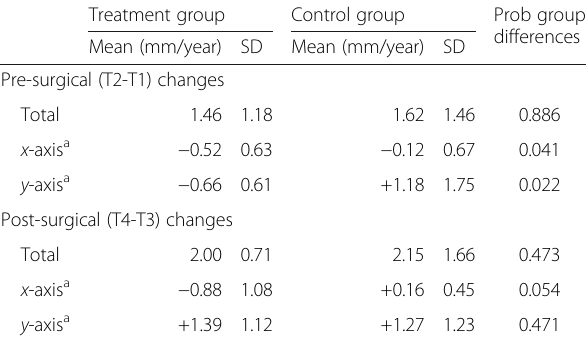
Table 4 Pre-and post-surgical growth changes of Co, along with statistical comparisons of the treatment and control groups Treatment group